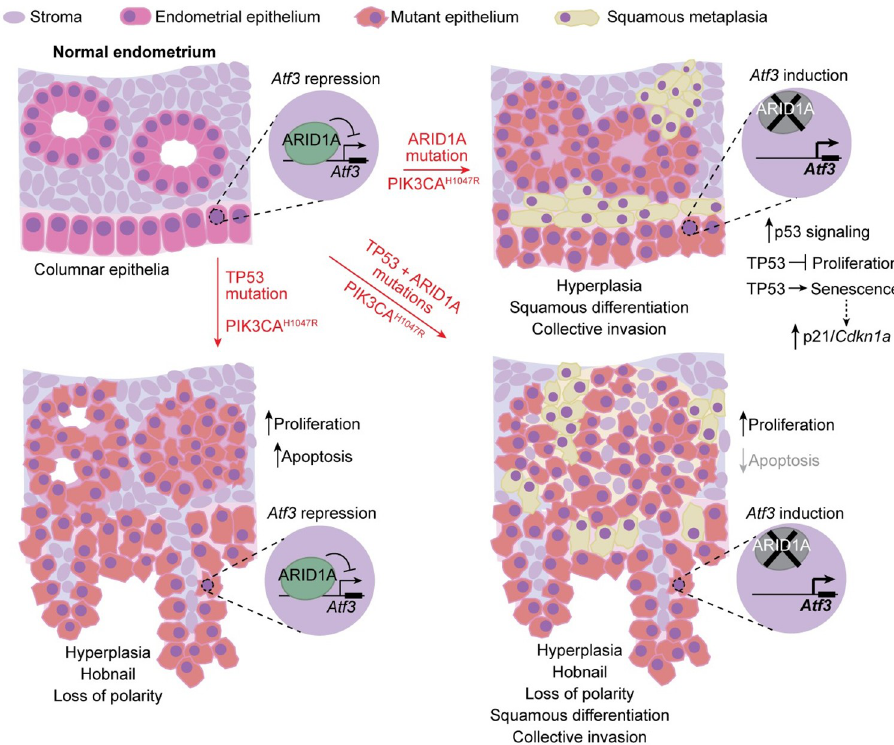
Fig 9. Model of independent and co-existing TP53 and ARID1A mutations in endometrial epithelia. Summary of endometrial disease features and hypothesized molecular mechanisms in genetically engineered mouse models from this